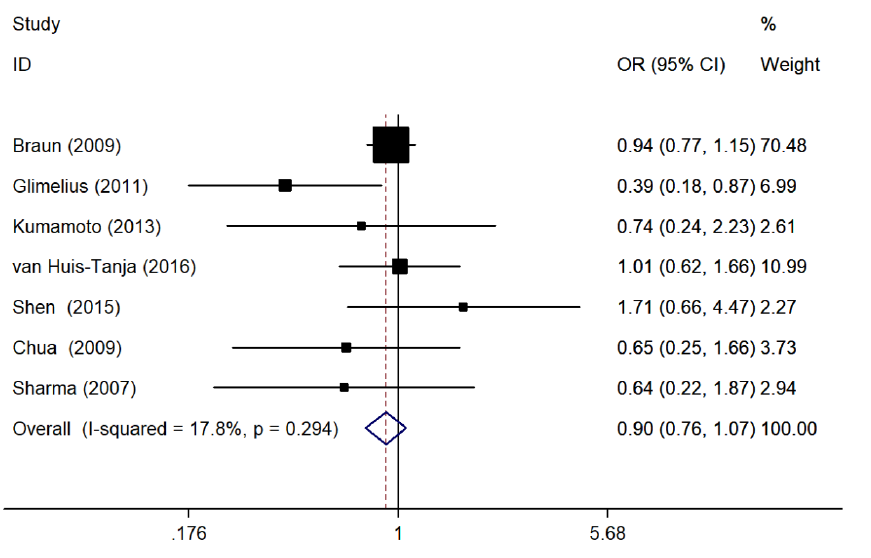
Figure 3: Forest plot of MTHFR gene rs1801133 C>T polymorphisms and chemosensitivity of colorectal cancer in recessive genetic model [(TT vs (CT+CC)].